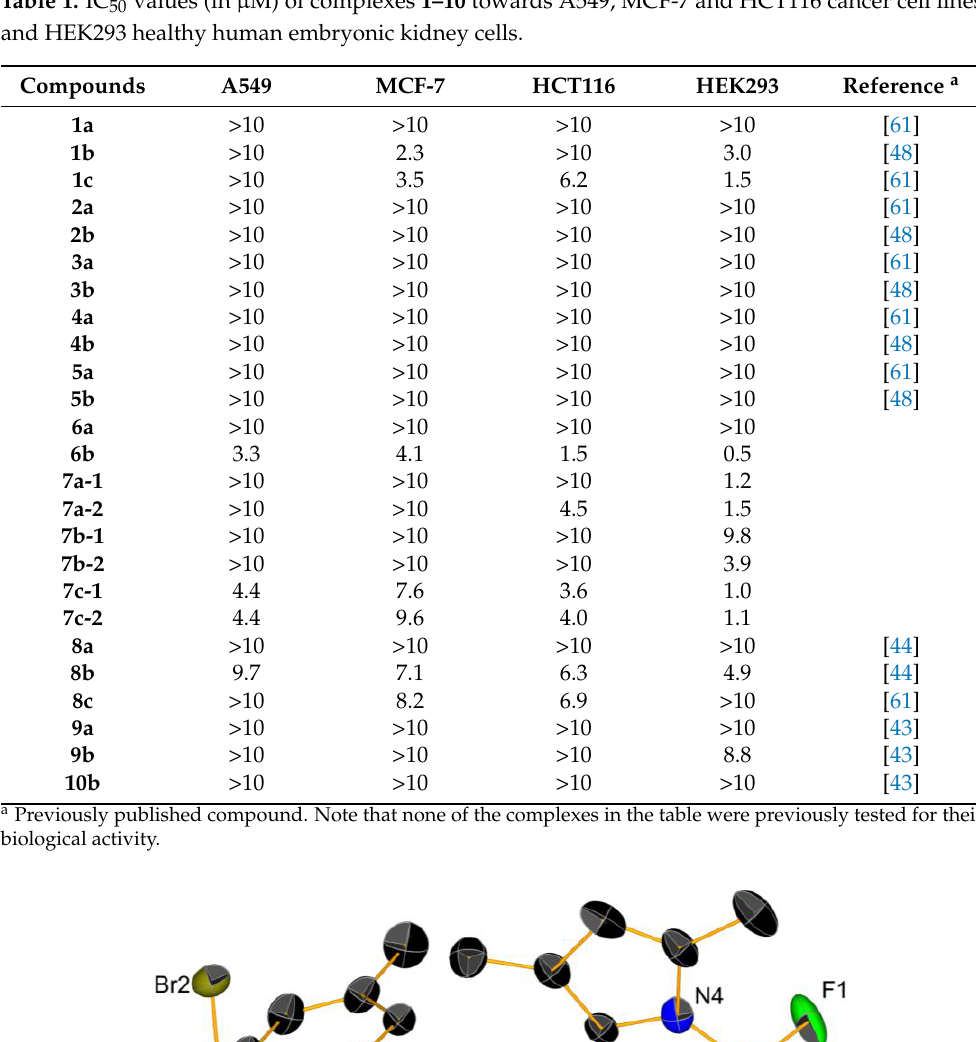
Table 1. IC 50 values (in µM) of complexes 1–10 towards A549, MCF-7 and HCT116 cancer cell lines and HEK293 healthy human embryonic kidney cells.